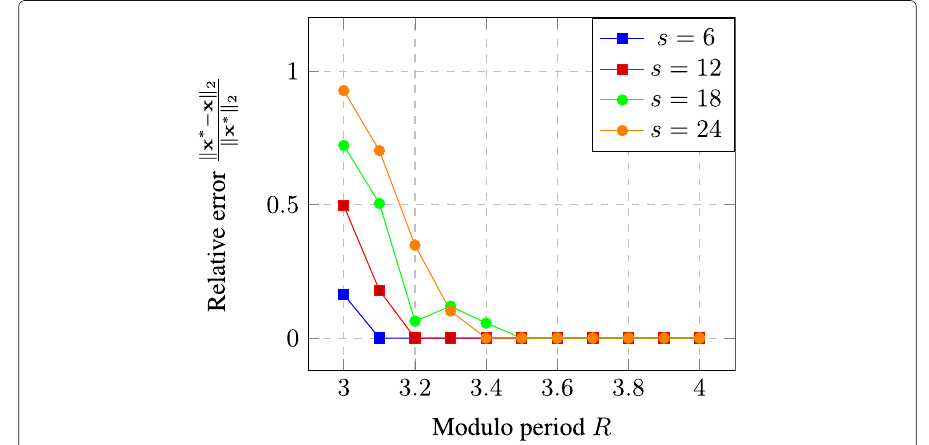
Fig. 6 Mean relative reconstruction error vs R for MoRAM with (cid:11) x ∗ (cid:11) 2 = 1, n = 1000, m =